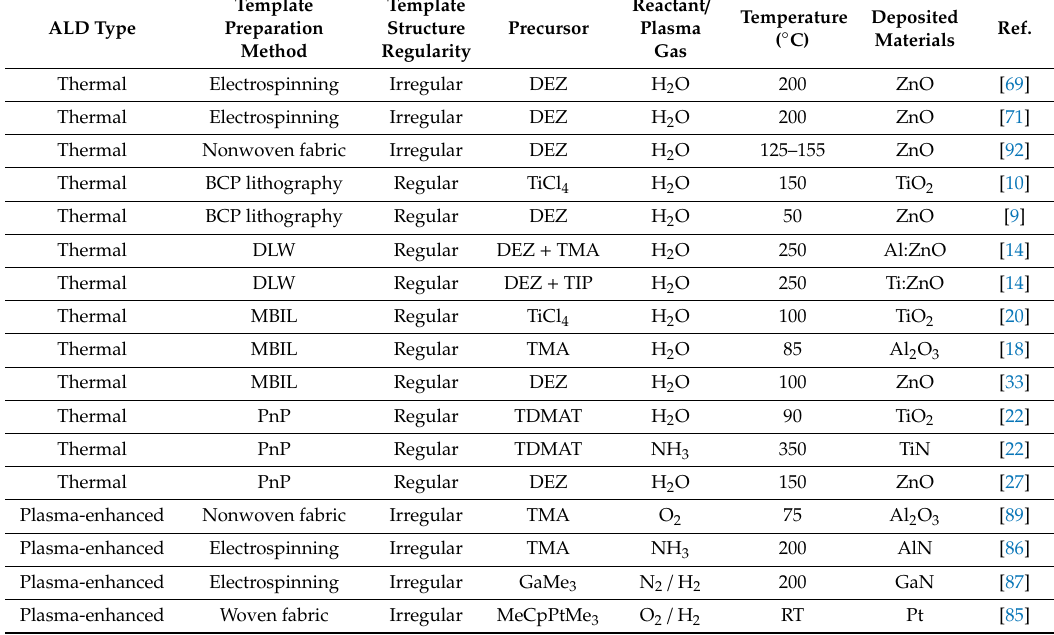
Table 1. The process parameters of selected cases of polymer template-assisted atomic layer deposition (ALD). Template ALD Type